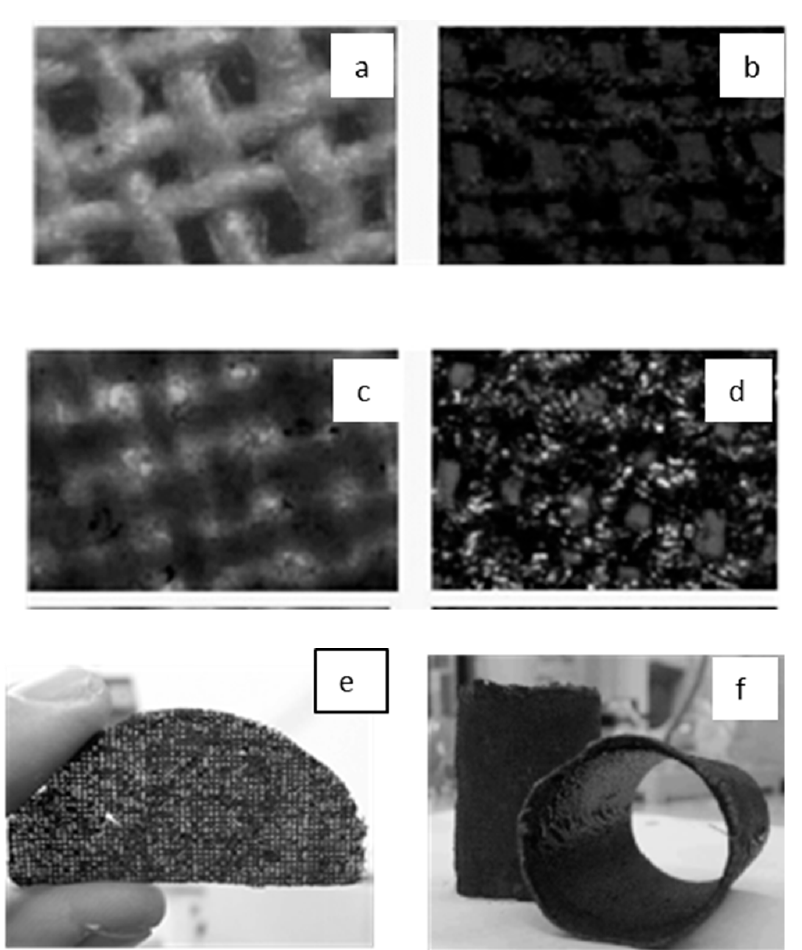
Figure 1. ( a – d ) Optical micrographs (60×) of ( a ) woven cellulose fiber fabric; ( b ) carbonized fabric ( a ); ( c ) fabric with adsorbed resin; ( d ) carbonized composite ( c ); ( e , f ) Photographs (1 × ) of: ( e ) one layer of fiber fabric with adsorbed RF resin; ( f ) cylinders made by attaching four layers of fiber fabric with adsorbed RF resin.